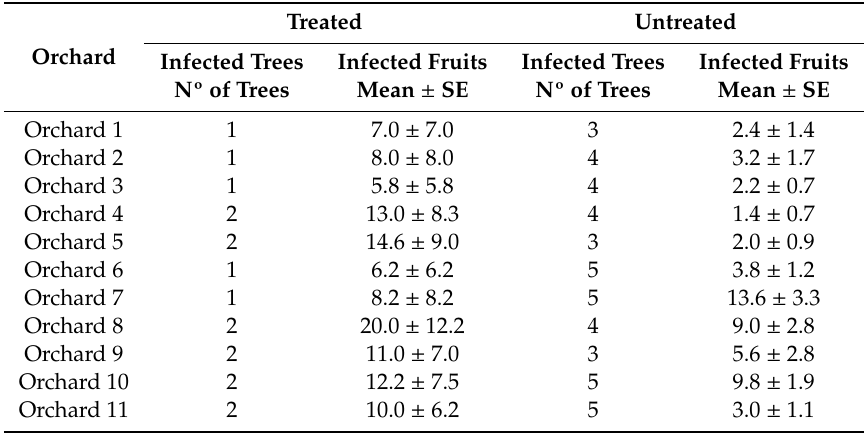
Figure 1. Principal coordinates analysis (PCO) based on the number of fruits showing the presence of Colletotrichum spp. dataset for the factor “management regime” (treated and untreated; 1 level, fixed). PCO1 = 88.5% and PCO2 = 10.9%. Table 1. Mean values ± standard error (SE) (per plot) of infected fruits (50 fruits per tree) and number of infected trees per orchard in Treated and Untreated orchards.